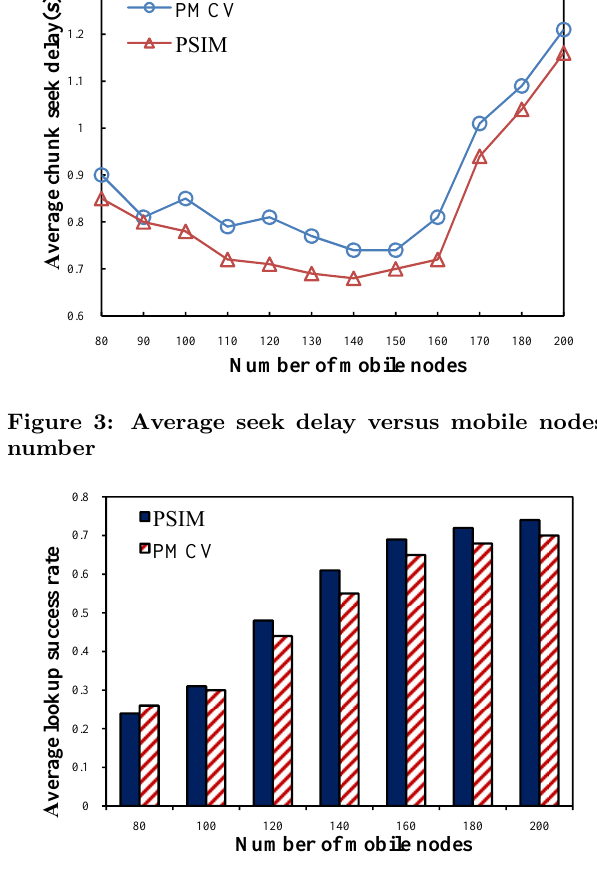
Figure 4: ALSR versus mobile nodes